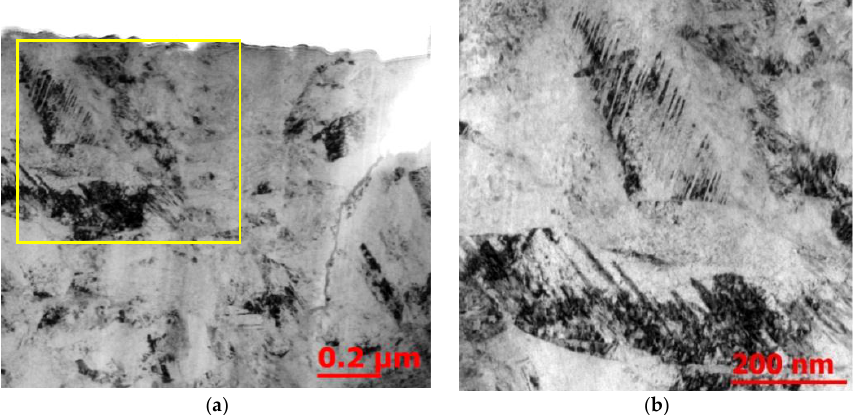
Figure 8. A ( a ) representative BF micrograph of the microstructure comprising the central WEL and ( b ) magnified view of the rectangle in ( a ).